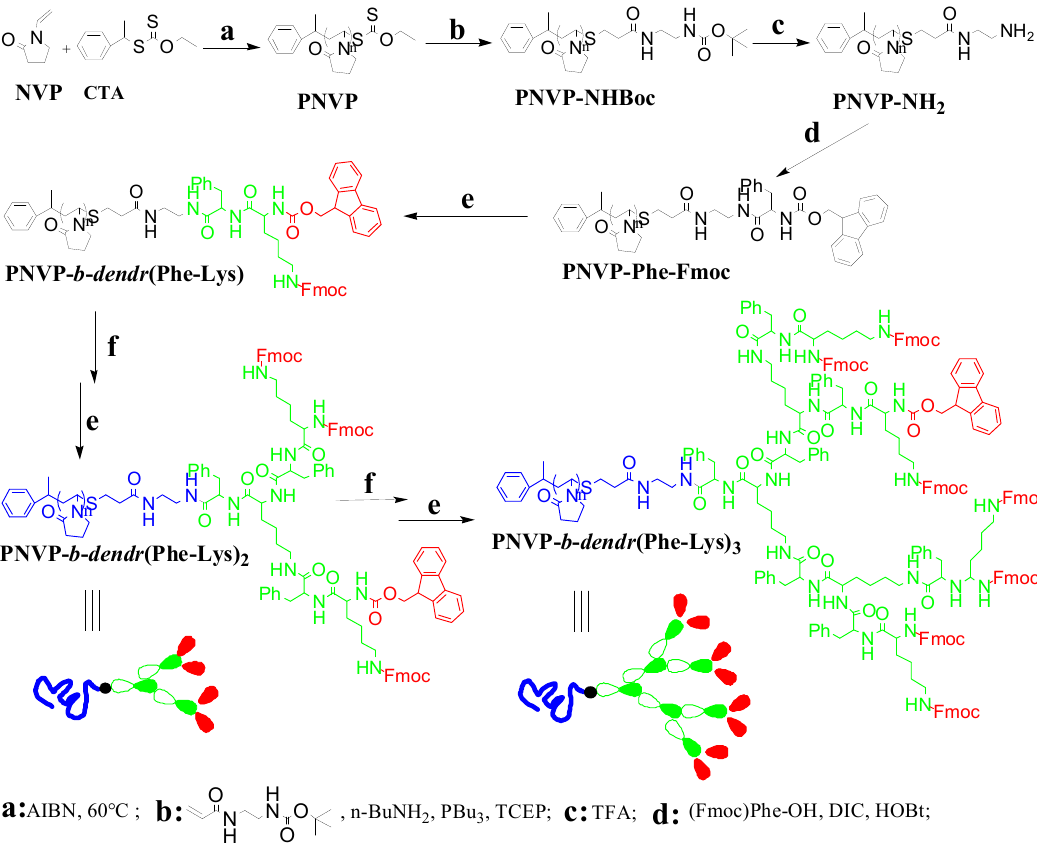
Scheme 1. Synthesis of amphiphilic linear-dendritic